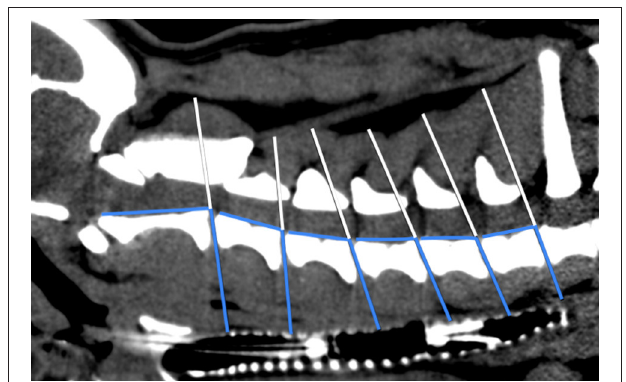
FIGURE 3 | Scheme of angle measurement in sagittal plane CT image. White line: level of each cervical intervertebral disk space; blue lines: angles between IVD spaces in relation to the axis of the cervical vertebral column.